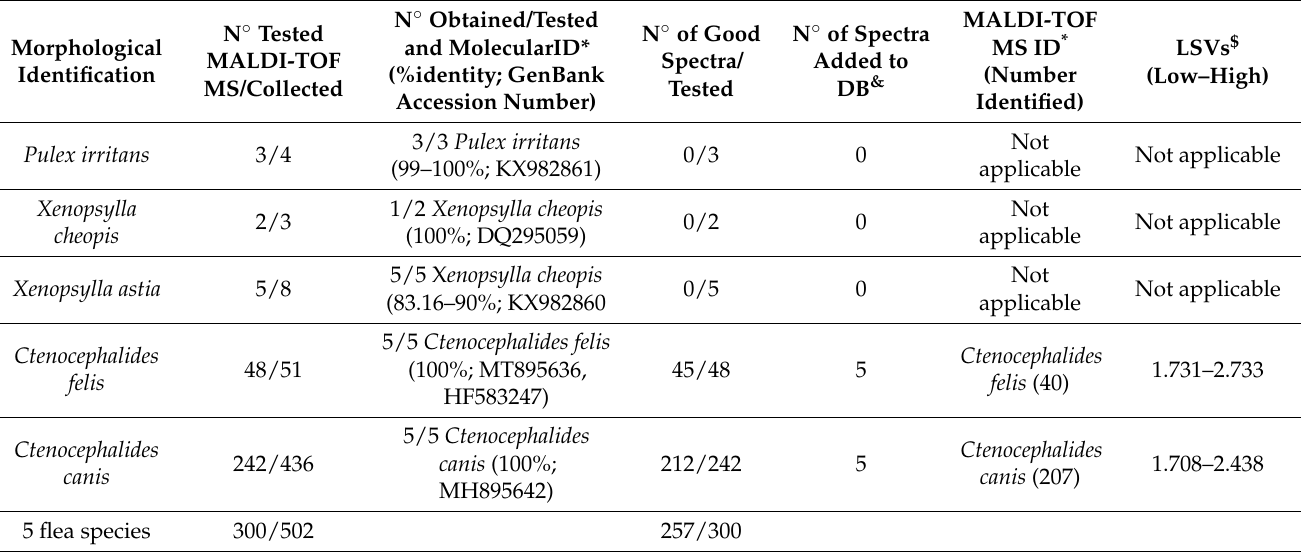
Table 2. The number of flea species analysed for protein profiling, development of the MS reference spectra, and validation of molecular